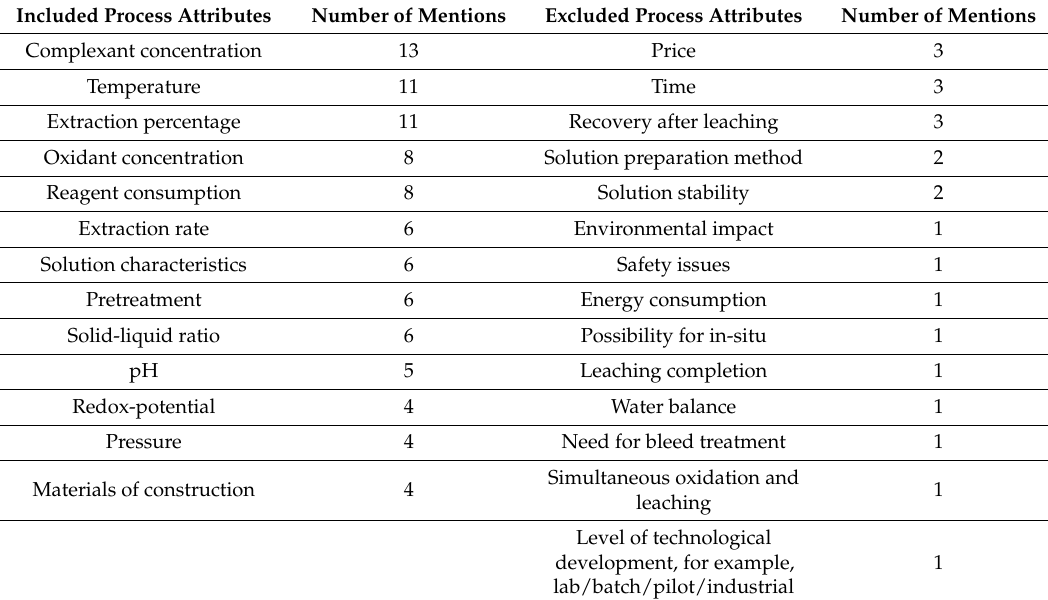
Table 1. Included and excluded process attributes sorted according to the number of mentions during